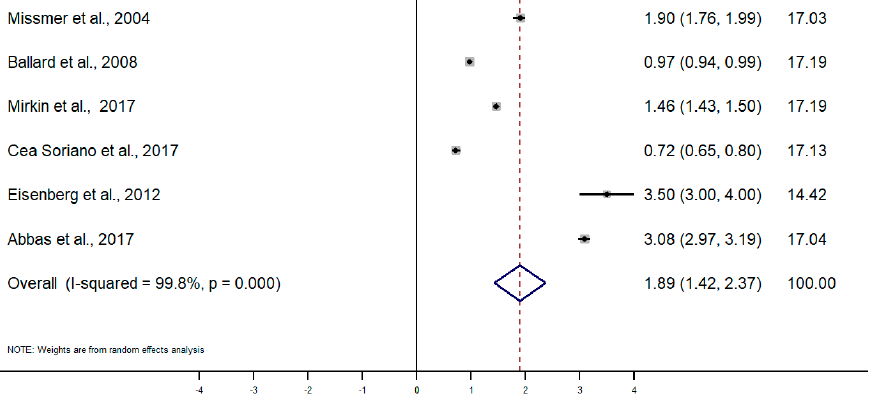
Figure 6. Meta-analysis of the incidence of endometriosis per 1000 person-years based on the data from cohort studies. Note: black lines with squared dots—the prevalence with confidence intervals for each individual study; rhombus—pooled prevalence with confidence interval; red dotted line—line of no effect (studies crossing the line are not statistically different).